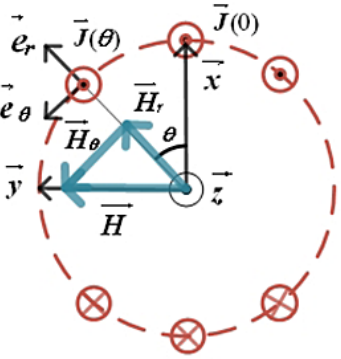
Figure 1. Current density distribution: (a) axisymmetric geometry in spherical coordinates, (b) plane geometry (infinite in z direction) in cylindrical coordinates. We adopt a unique angle notation for the two problems by substituting the usual ϕ (in the cylindrical coordi- nates) by θ .